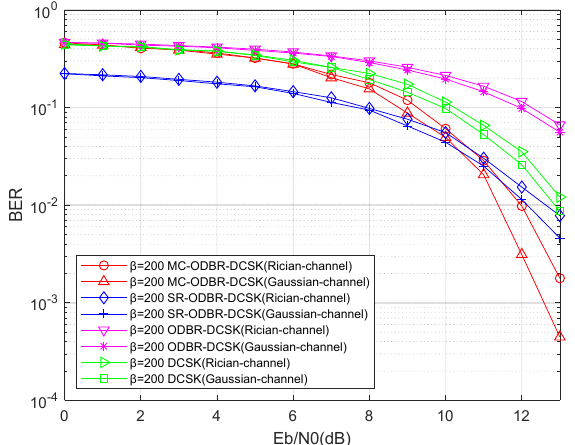
Figure 12. Comparison of bit error rates of DCSK, ODBR − DCSK, SR − ODBR − DCSK, and MC − ODBR-DCSK systems in Gaussian and Rician channels.